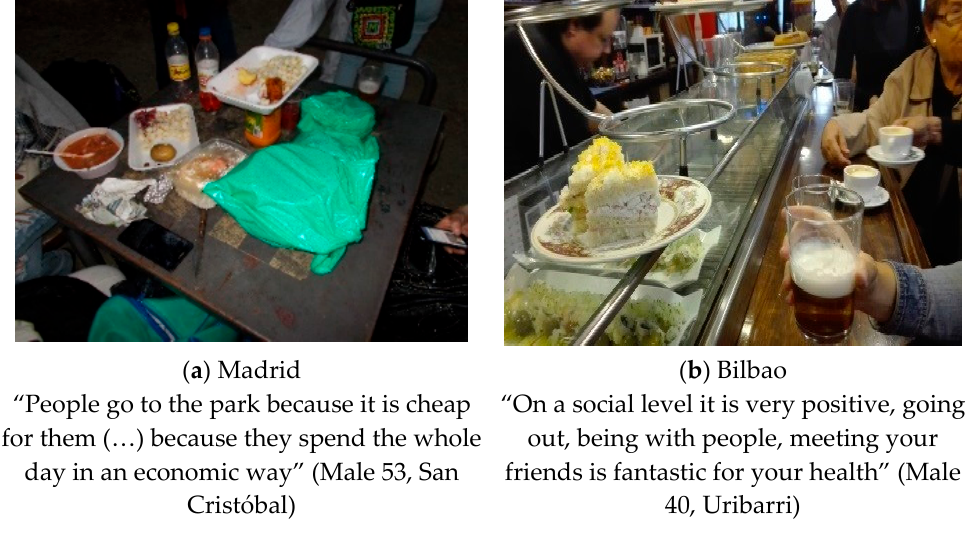
Figure 3. ( a ) Photograph made in Madrid: “Eating in the park”. Category: Street food. Theme: social gatherings; ( b ) Photograph made in Bilbao: “Pintxo-pote”. Category: Pintxos. Theme: Social outdoor outings.